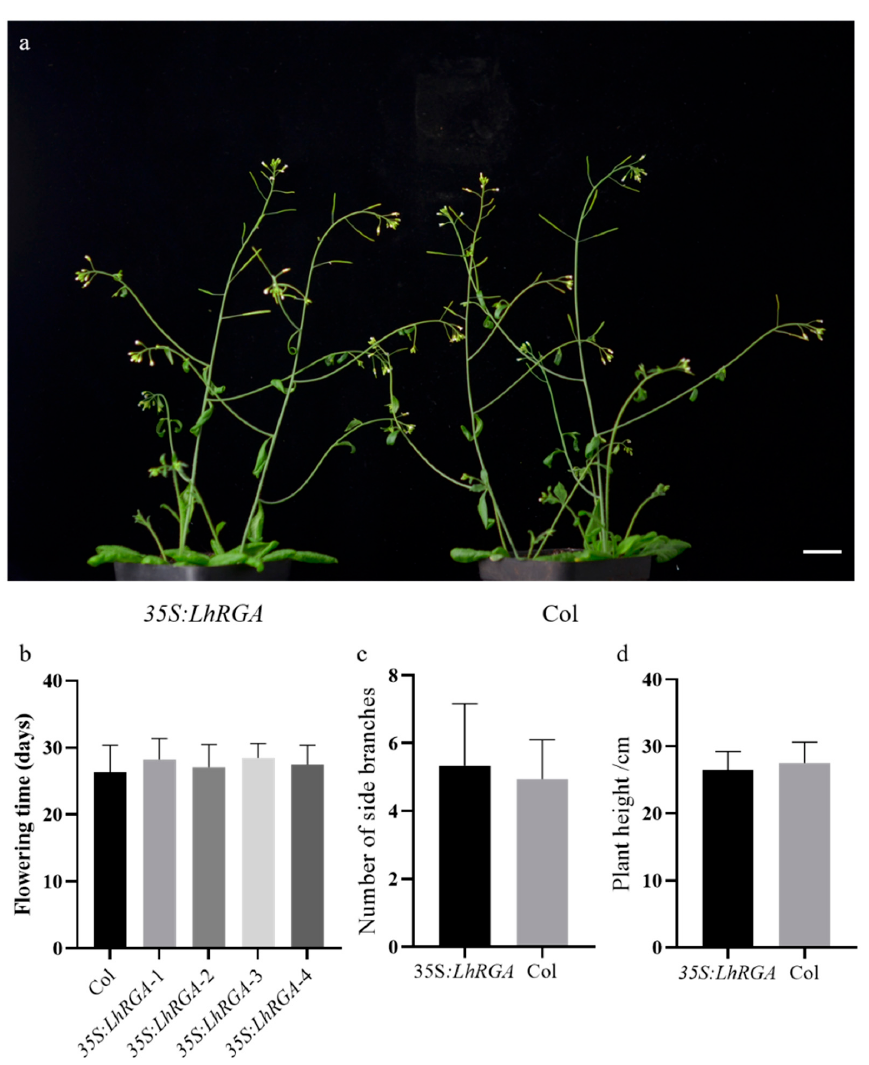
Figure 6. Morphological phenotypes of Arabidopsis overexpressing LhRGA . ( a ) Phenotypes of 30-day-old wild-type and transgenic plants. Scale bars = 2 cm ( b ) Measurement of flowering time in the wild-type and transgenic lines ( a ). Error bars: ± SD. ( c ) Number of side branches in the wild-type and transgenic lines ( a ). Error bars: ± SD. ( d ) Measurement of plant height branches in the wild-type and transgenic lines ( a ). Error bars: ± SD.